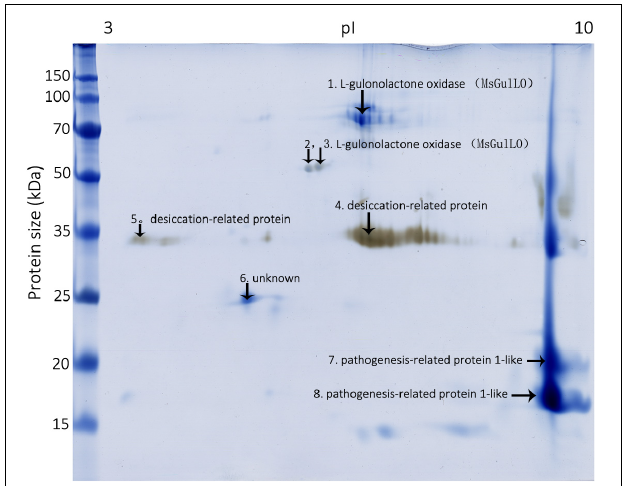
FIGURE 2 | Mucuna sempervirens nectarines on 2D gel. Identified nectar proteins on the gel, including MsGulLO, are indicated by arrows.